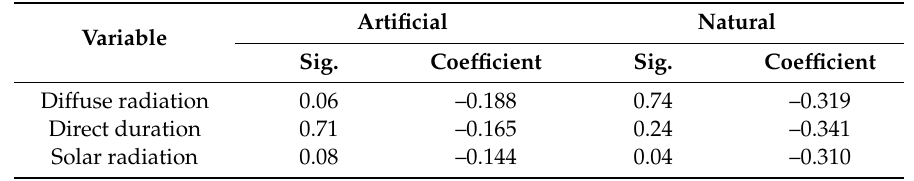
Table 5. Illustration of the Pearson correlation between the regeneration and potential solar parameters derived from the